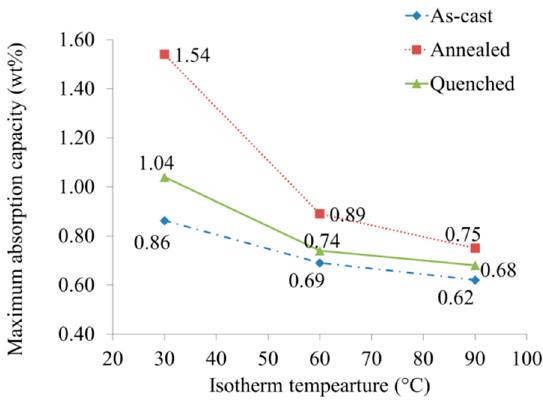
Figure 4. Influence of isotherm temperatures on maximum hydrogen capacity.